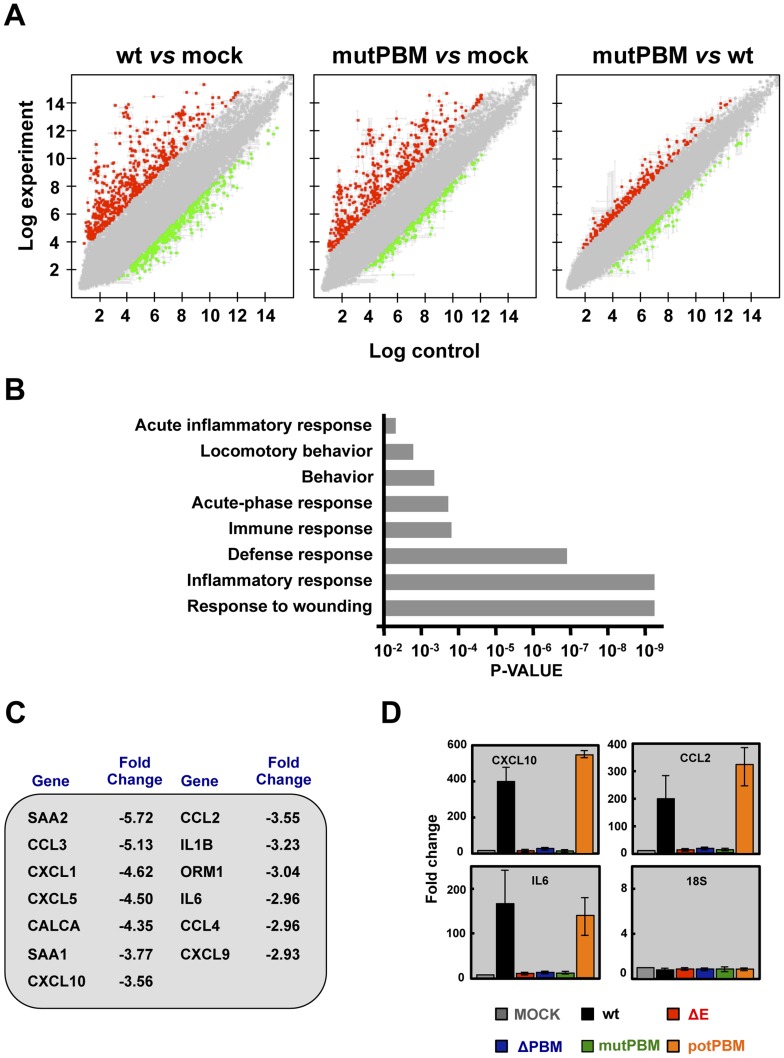
Effect of SARS-CoV E protein PBM on host gene expression.(A) Comparison of gene expression in lungs of infected mice using microarrays: wt versus mock-infected, mutPBM versus mock-infected and mutPBM versus wt-infected mice. Red spots indicate upregulated gene transcripts (fold change, >2) and green spots indicate downregulated gene transcripts (fold change, <−2). Only genes with a FDR of <0.01 were considered as candidate genes. (B) Candidate genes that were downregulated in mutPBM infected mice compared wt infected ones, were grouped on Gene Ontology terms. Numbers on the x axis indicate DAVID FDR values. (C) Selection of differentially expressed genes found in at least one functional group using DAVID software. The numbers indicate the fold change for each gene in mutPBM versus wt-infected mice. (D) Expression of inflammatory cytokines evaluated by RT-qPCR. Three independent experiments were analyzed with similar results in all cases. Error bars represent standard deviations of the mean of results from three experiments.